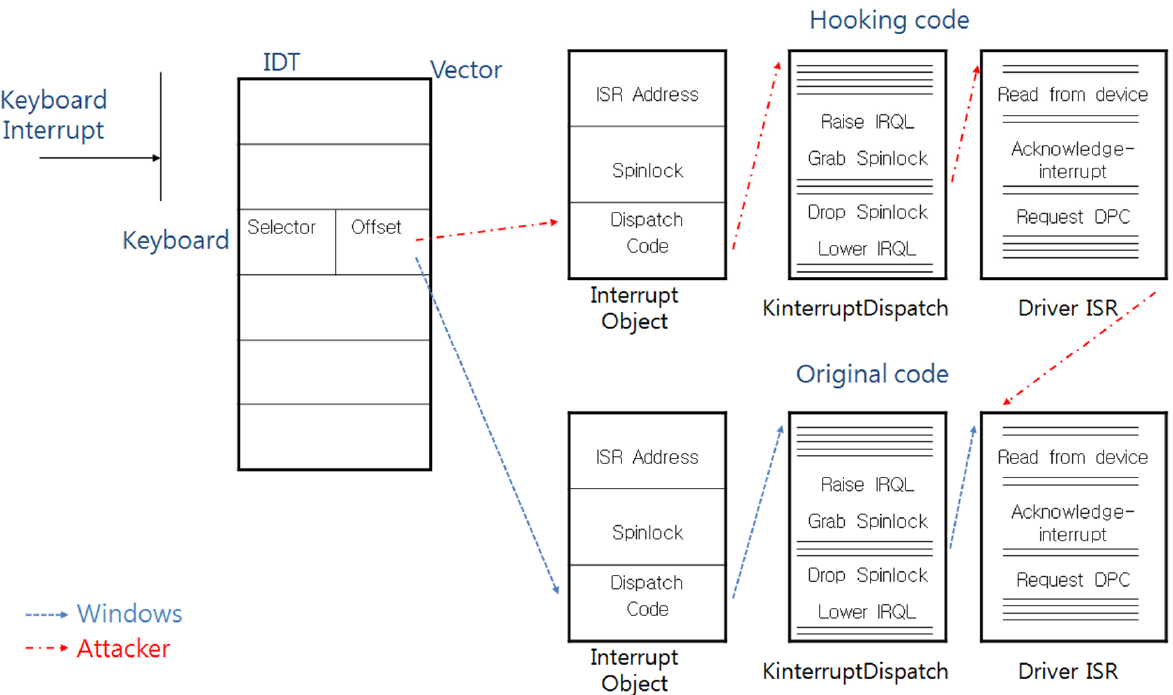
Figure 5. The calling process after the IDT is replaced by the attacker.